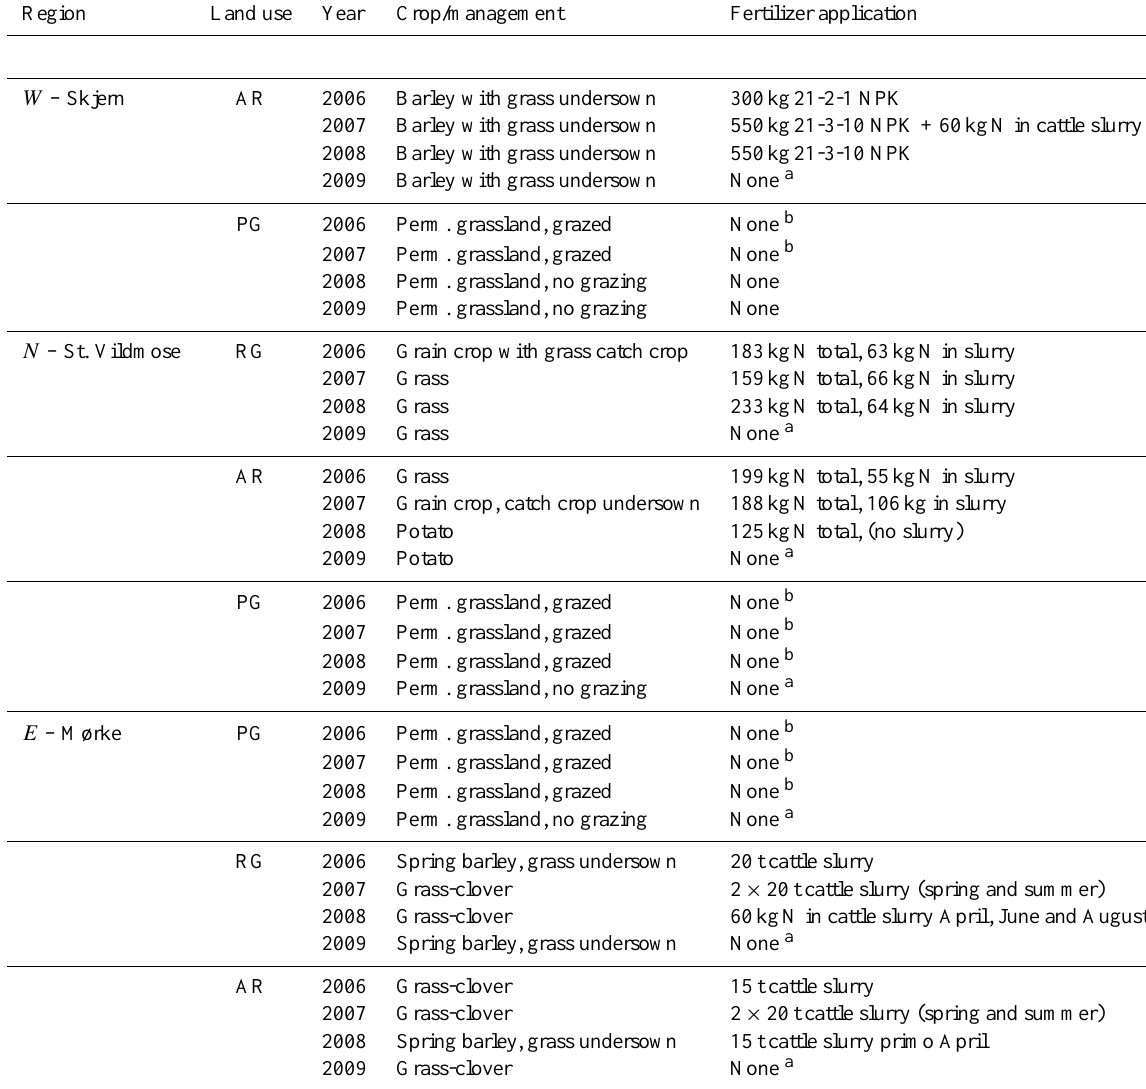
Table 2. Land use and N inputs via mineral fertilizers and manure during the period 2006–2009 at the eight monitoring sites. AR – arable crop; PG – permanent grassland; RG – rotational